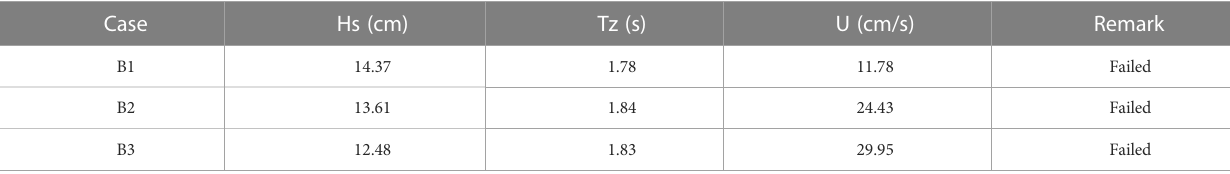
TABLE 3 Input irregular wave and current conditions in model test